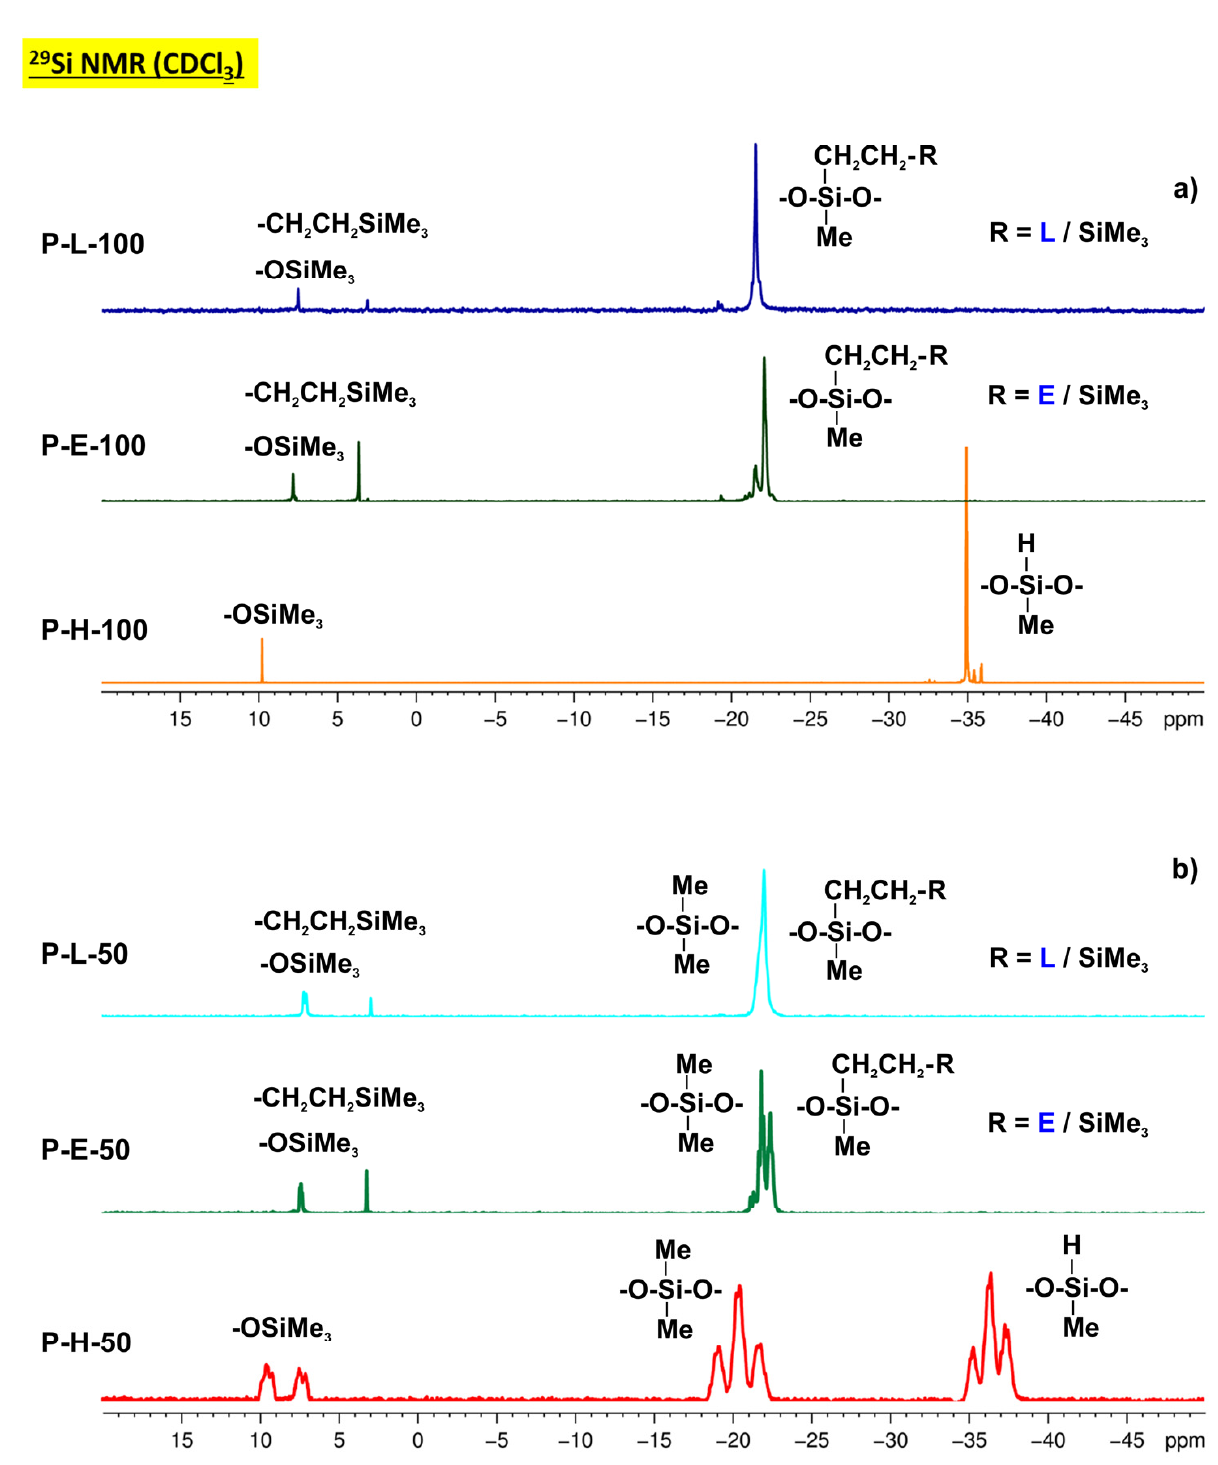
Figure 1. 29 Si NMR spectra of linear polysiloxanes grafted with eugenol and linalool (compared to their precursors P-H-100 ( a ) and P-H-50 ( b )).